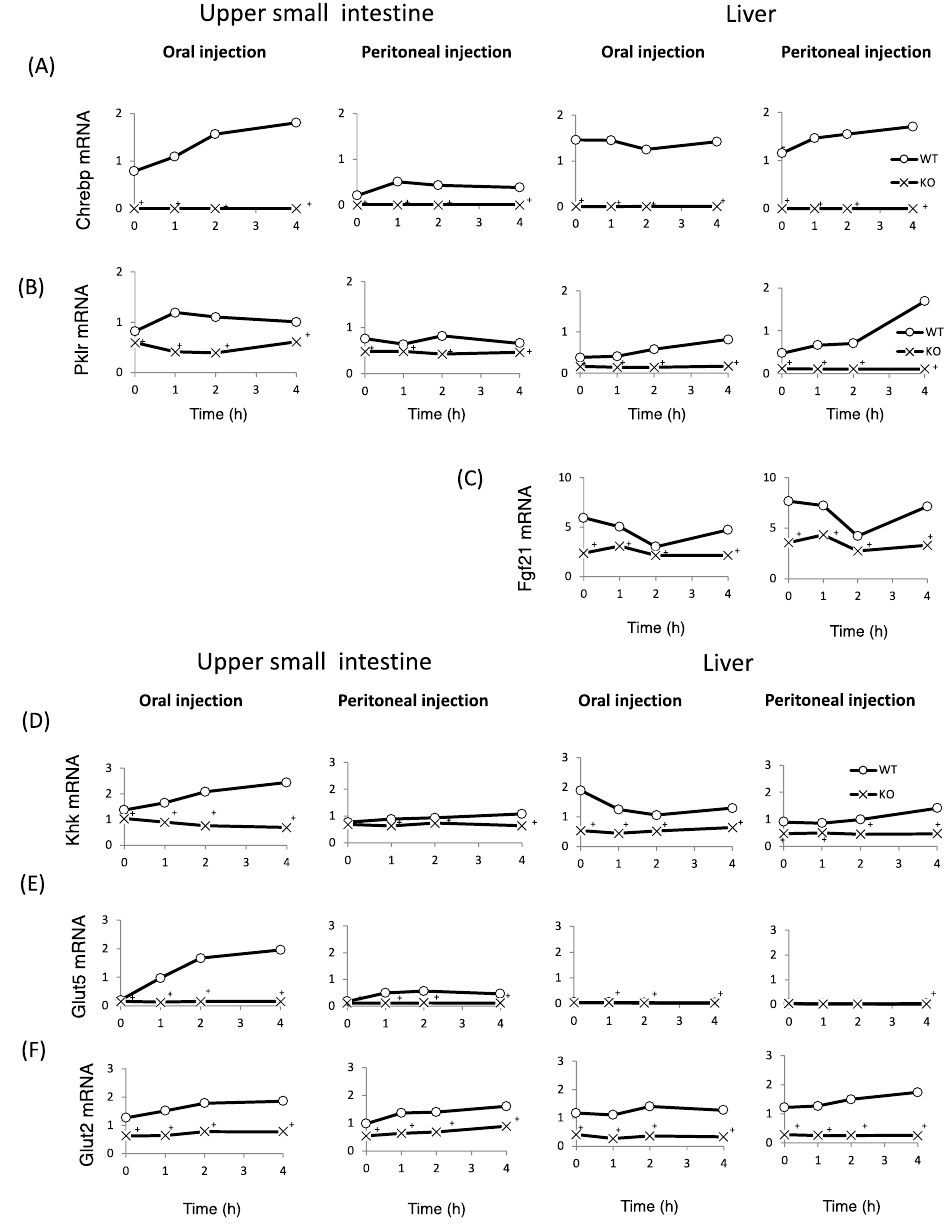
Figure 5. The effect of oral and peritoneal fructose injection on genes related to ChREBP and fructose metabolism. After oral or peritoneal fructose injection (3 kg/kg BW), the mRNA expression of ChREBP ( A ); liver type pyruvate kinase ( Pklr ) ( B ); fibroblast growth factor-21 ( Fgf21 ) ( C ); ketohexokinase ( Khk ) ( D ); glucose transporter 5 ( Glut5 ) ( E ); and glucose transporte 2 ( Glut2 ) ( F ) in the intestine and liver was measured by real-time PCR analysis. n = 3 per group. + WT vs. KO, p <